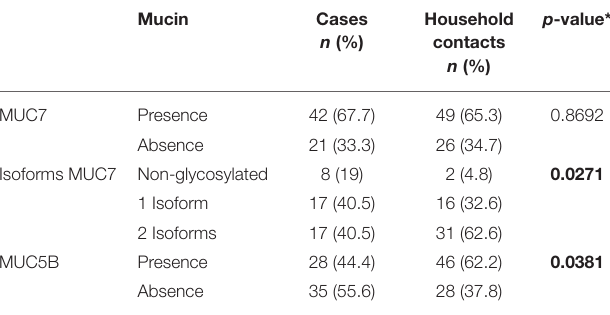
TABLE 2 | Analysis of salivary proteins MUC7 and MUC5B in cases and close household